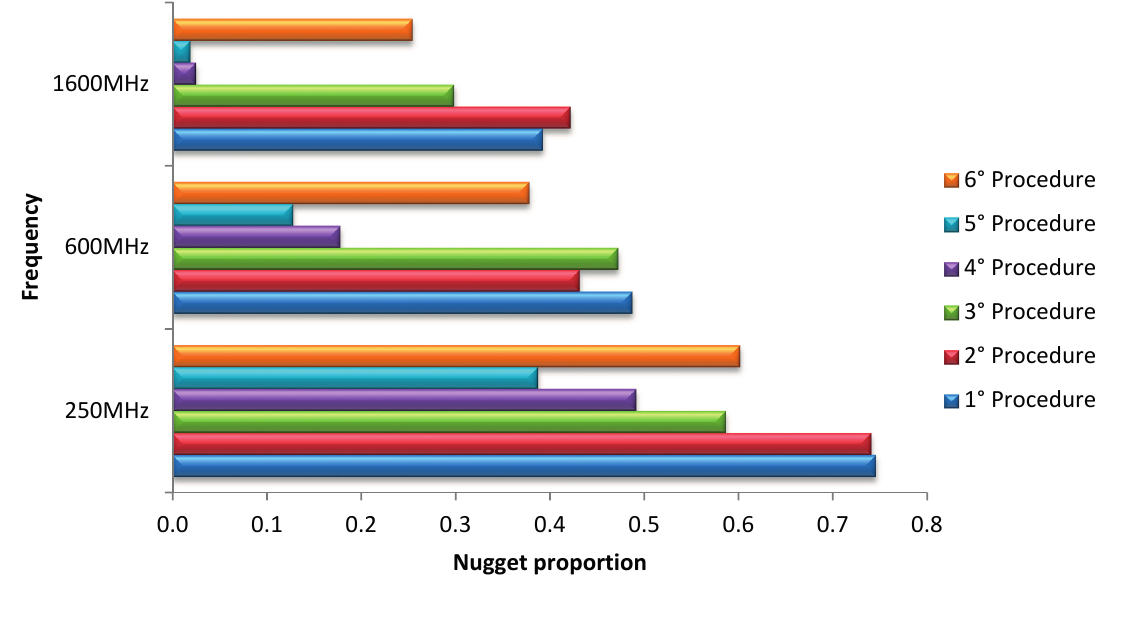
Figure 11. Variance proportion explained by nugget component for each used processing procedure and for each